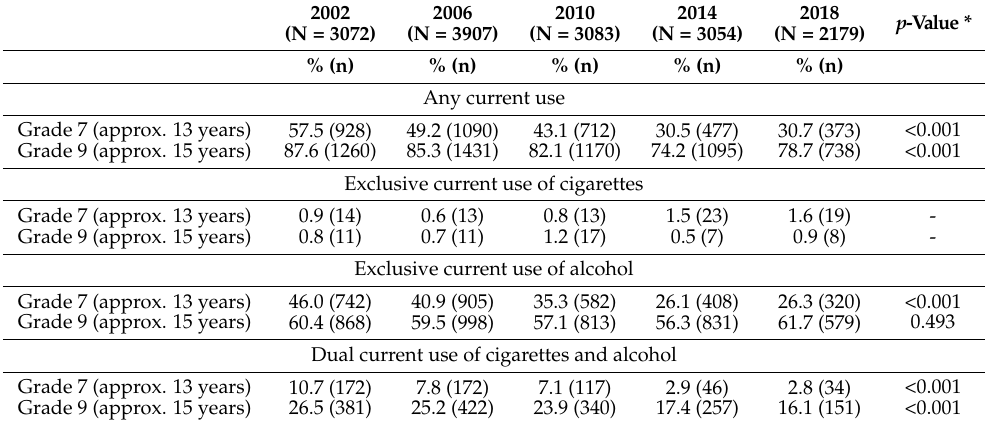
Table 3. Current substance use at five time points, 2002–2018, according to age